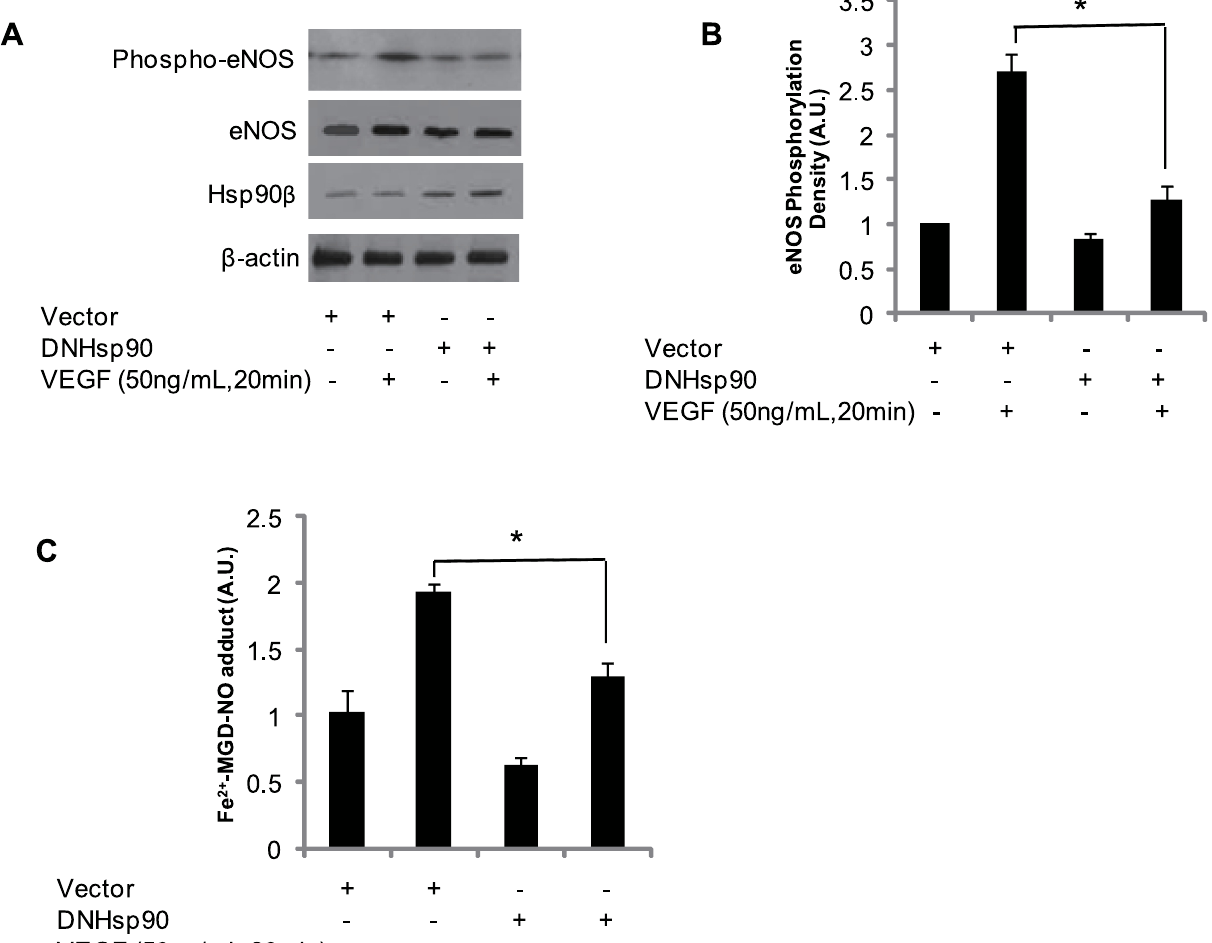
Fig 8. Dominant negative Hsp90 inhibited VEGF-mediated eNOS phosphorylation and NO generation from BAECs. (A and B) Overexpression of DNHsp90 in BAECs increasedHsp90 β expressionand significantly inhibitedVEGF-mediated eNOS phosphorylation (P < 0.05comparedto control; n = 4); (C) Fe2+-MGD-NO adduct signal density assay showedthat DNHsp90 also significantly inhibited VEGF-mediated NO generationfrom BAECs (P < 0.05comparedto control; n =